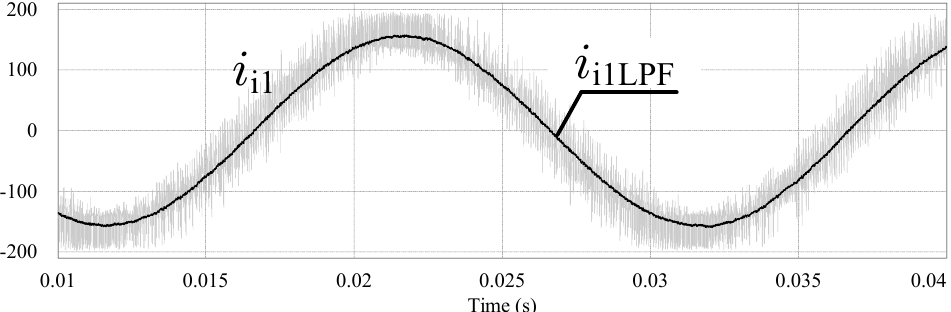
Figure 27. An input current i i1 and its filtered waveform i i1LPF for NVM modulation: THD ( i i1 ) =